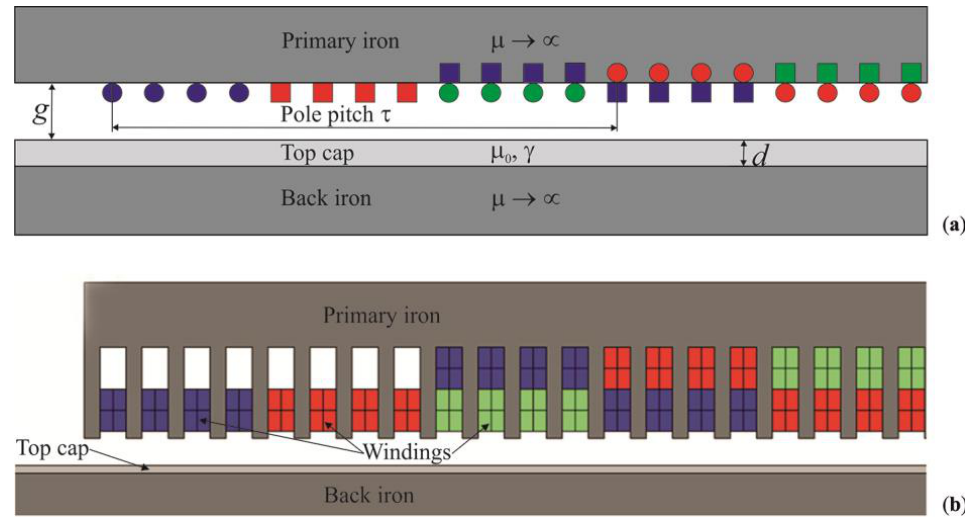
Figure 7. Evolution of 2D models of the LIM used for the numerical field evaluation. Idealized coils of a three-phase, six-pole machine [62] ( a ). Full model of the LIM [70] ( b ).